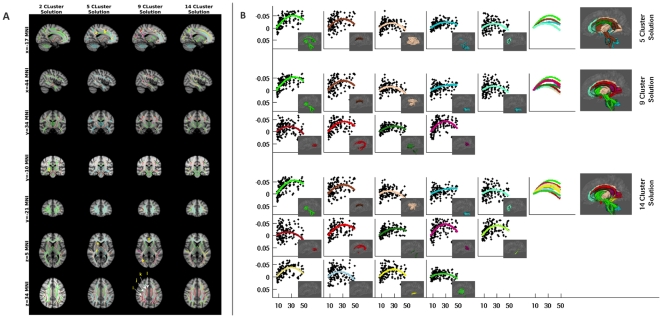
Optimal Cluster Solutions.
Panel A (Skeletonized Fractional Anisotropy [FA]): The 5-, 9- and 14- cluster solutions identified by the Davies-Bouldin cluster validation index as optimal are depicted here, along with the 2-cluster solution, for reference. Cluster analysis recapitulated well-established white matter tracts, as well as key distinctions within white matter tracts. Notable examples include separation of the corpus callosum (CC) into three major divisions (splenium, body, genu) and differentiation of anterior and posterior limb of the internal capsule. Across all solutions, the cerebral peduncles and anterior limb of the internal capsule demonstrated consistent clustering patterns, likely reflecting fronto-pontine pathways. Tract Marker Key: [A: splenium (CC), B: body (CC), C: genu (CC), D: corticospinal tract (marked at interface with cerebral peduncle), E: anterior limb of the internal capsule, F: posterior limb of the internal capsule, G: forceps minor, H: optic radiations, I: superior longitudinal fasciculus, J: superior corona radiata, K: body (CC), L: cingulum bundle]. Panel B (Trajectories and Atlas-Based Projections): For each of the optimal cluster solutions (5-, 9- and 14-clusters), we depict the mean trajectory across voxels in each of the clusters; all trajectories are baselined with respect to the initial trajectory value to facilitate visual comparison. Values on the ordinates represent change in FA from the initial value obtained for each trajectory for each cluster. Age in years is shown on the abscissas. Across clusters, the mean age at which peak FA was reached was 30.1 years. To facilitate visualization, we provide ICBM-81 atlas-based tract projections, with each tract color-coded based upon the dominant cluster to which its voxels were assigned (note: clusters 11 and 12 were not dominant in any atlas-based tract). Immediately to the left of each anatomic projection is the overlay of the trajectories for each solution.